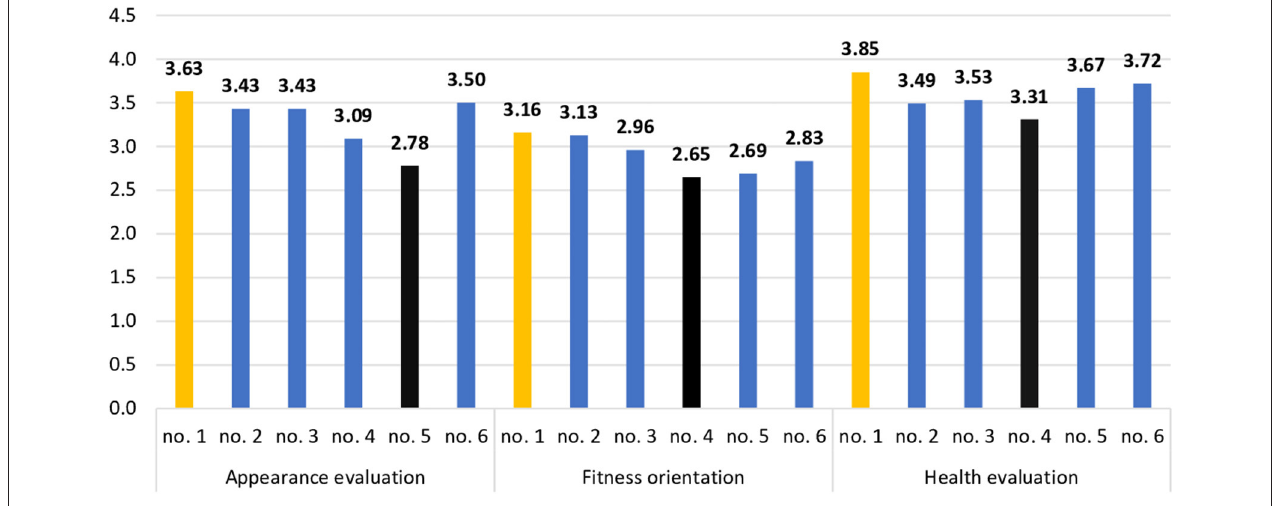
FIGURE 2 | Statistically significant relationships between profiles of perceived support and body image in the group of pregnant